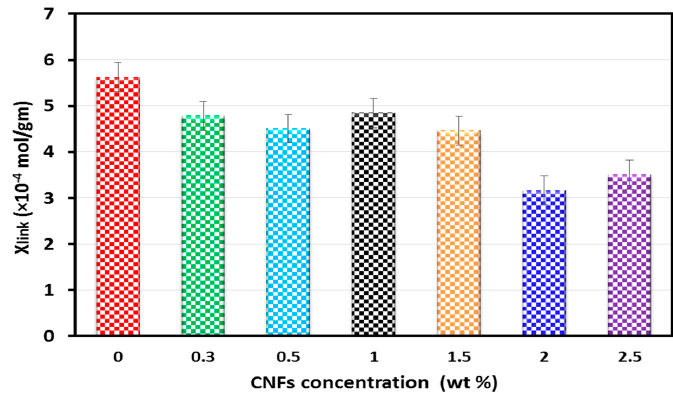
Figure 7. The degree of crosslinking for CNFs/epoxy nanocomposites.